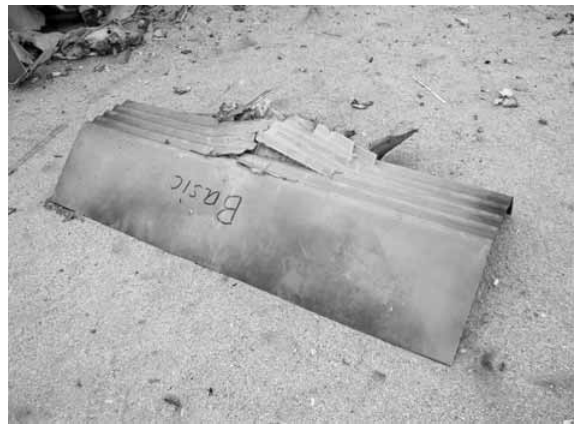
Fig. 34. Basic shield after test (outside view).